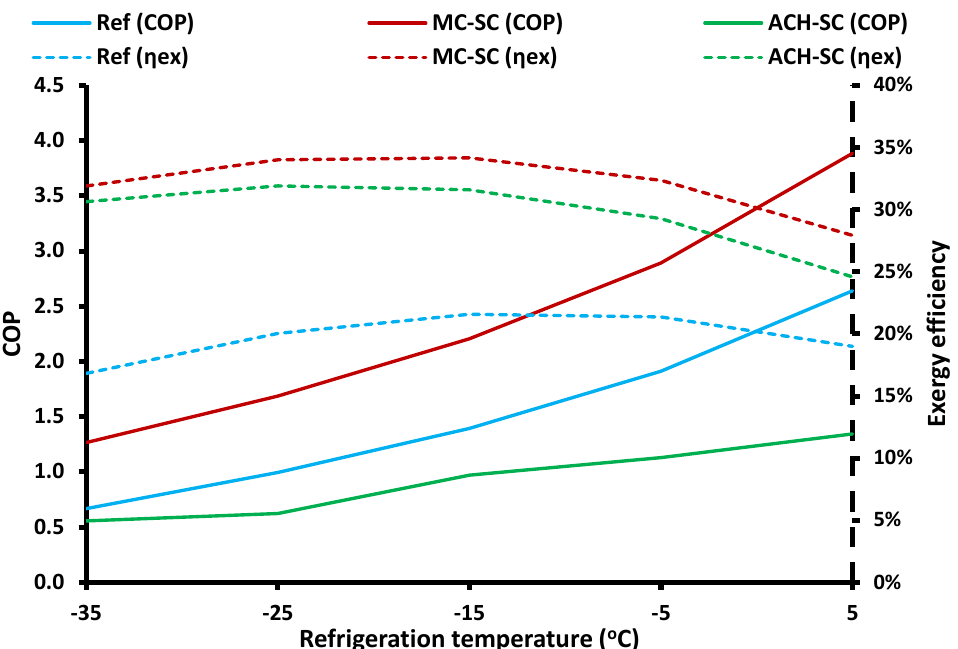
Figure 16. COP and exergy efficiency comparison of the optimized cases of the three systems (T c = 40 °C).